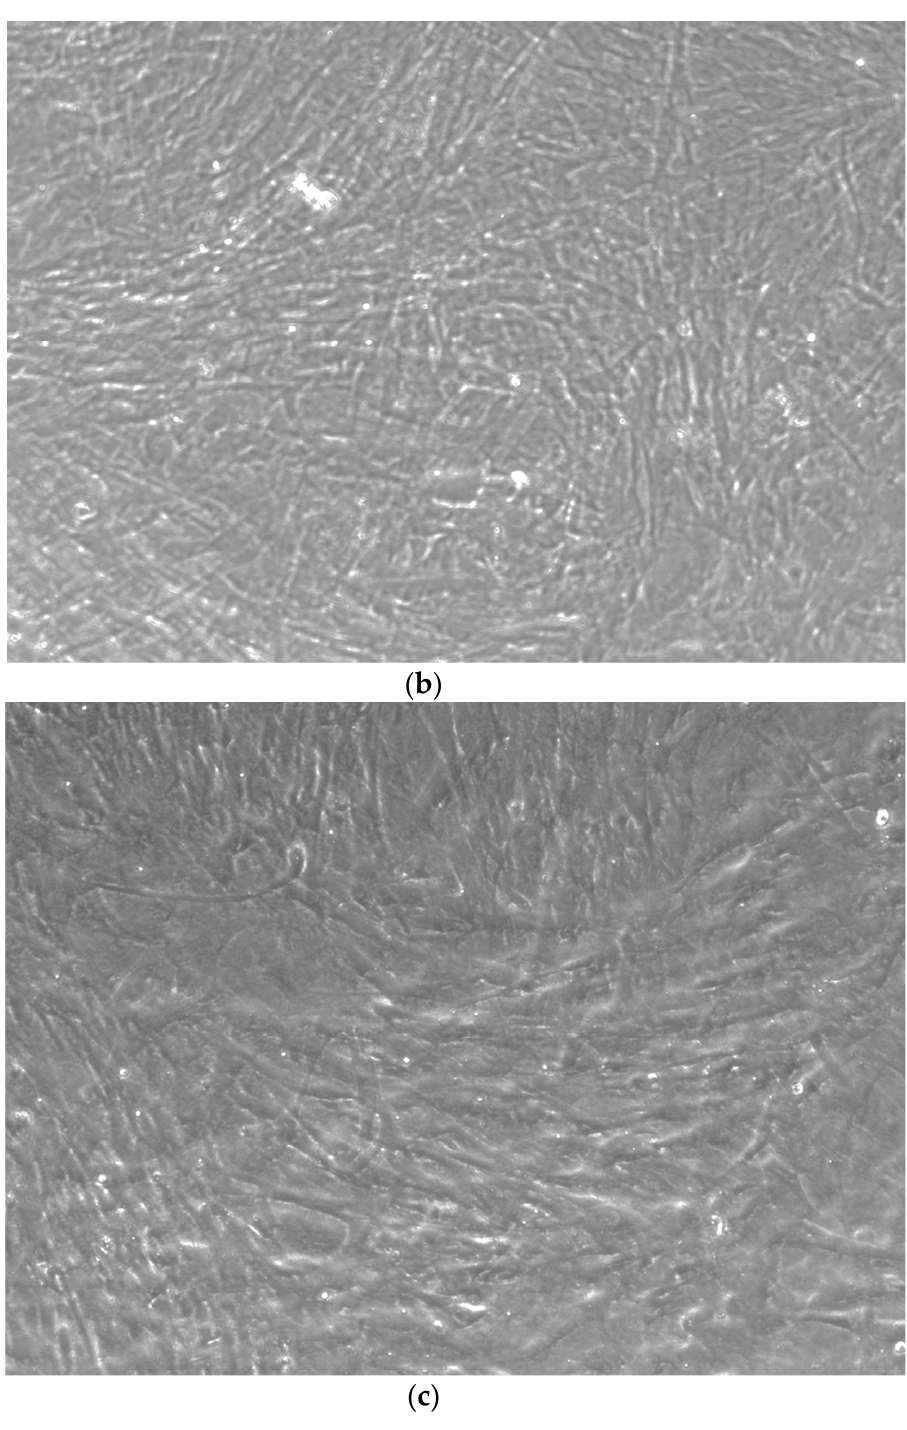
Figure 4. CTR4#5 P20 showed a different structure since the first days of differentiation compared to other clones; these optical microscopic phase images are, respectively, at 7 ( a ), 14 ( b ), 26 ( c ) days and do not show the typical concentric structure of the lamellar bone, but rather a highly disorganized structure.